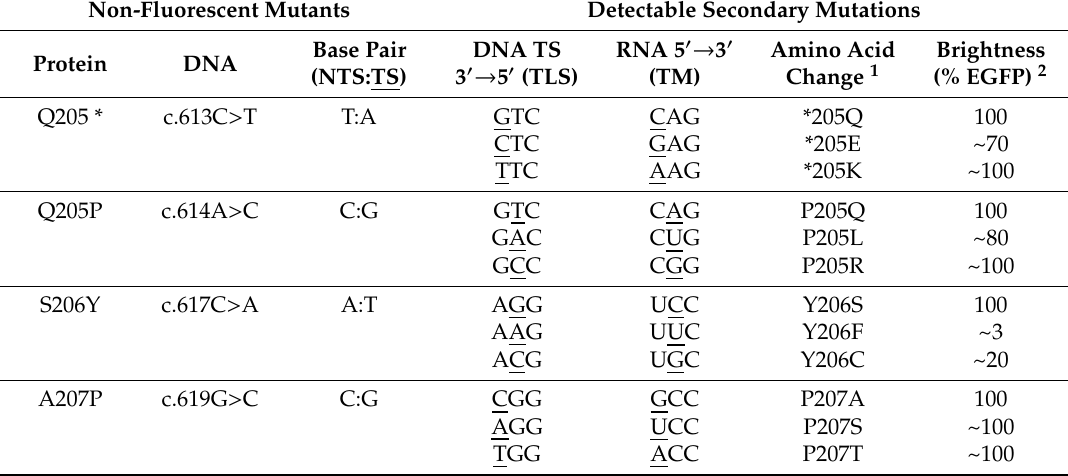
Table 2. Summary of the loss-of-fluorescence EGFP mutants convertible to fluorescent protein species by the indicated single nucleotide substitutions (underlined) and EGFP phenotypes of the analyzed secondary mutations in the